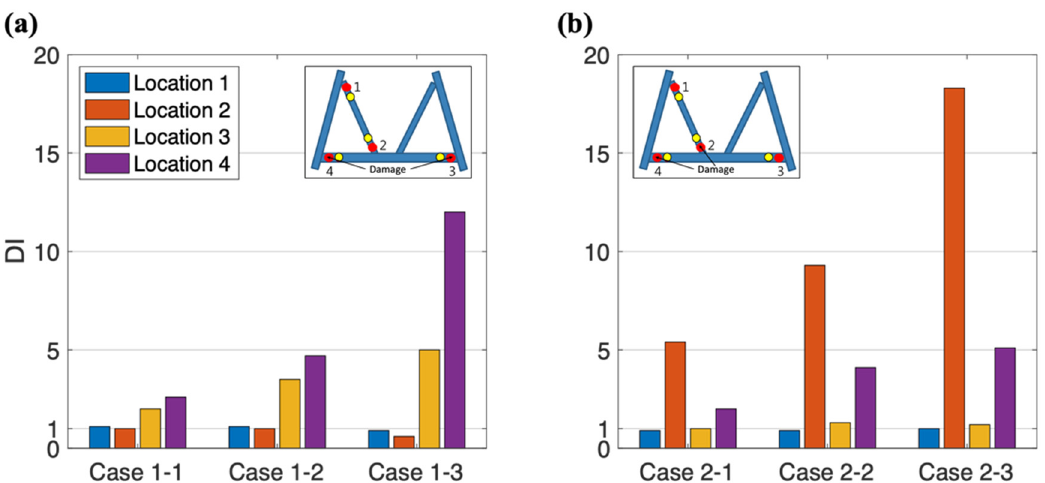
Figure 5. Same damage in multiple locations for ( a ) Case 1 (damage in the same pipe) and ( b ) Case 2 (damage in different pipes).